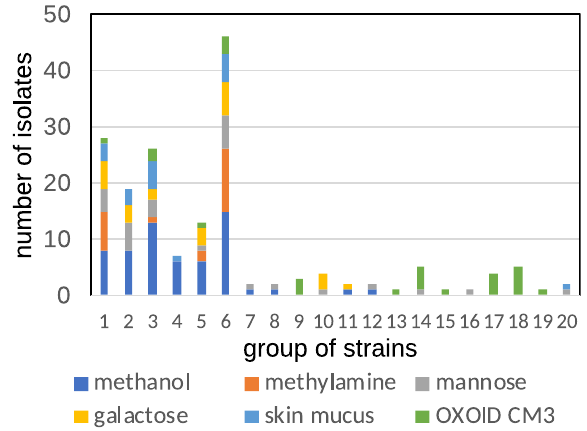
Figure 1. Numbers of isolates classified for strain group, composition of culture